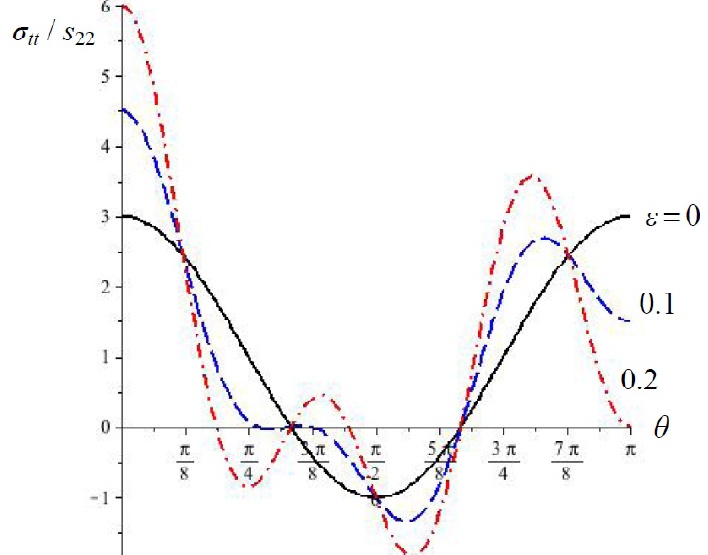
Fig. 4. Distribution of the tangential stress  values of the parameter  :  =0 (the solid curve), 0.1 (the dashed curve), and 0.2 (the dashed-and-dotted